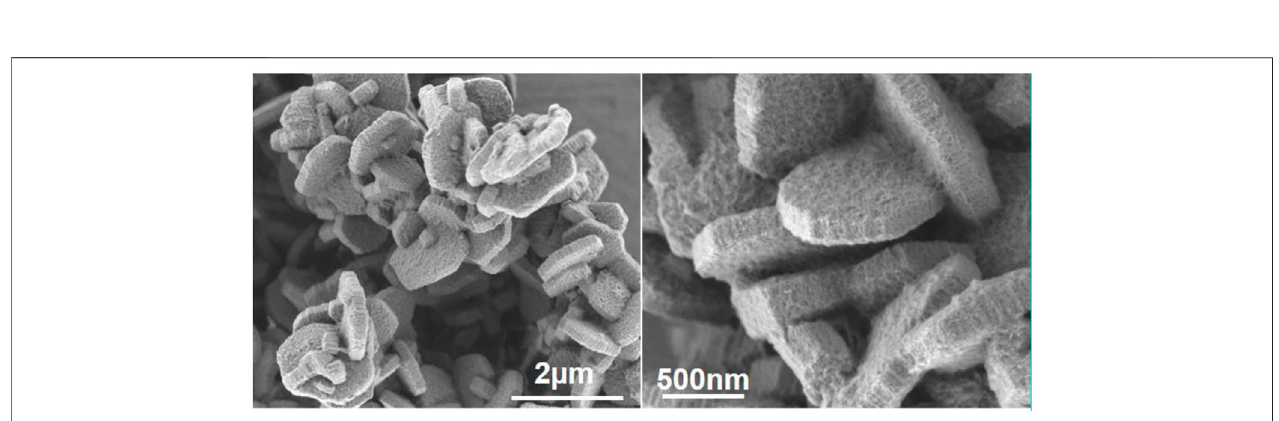
FIGURE 14 | HR-SEM images revealing the hexagonal platelet morphology of COK-12.